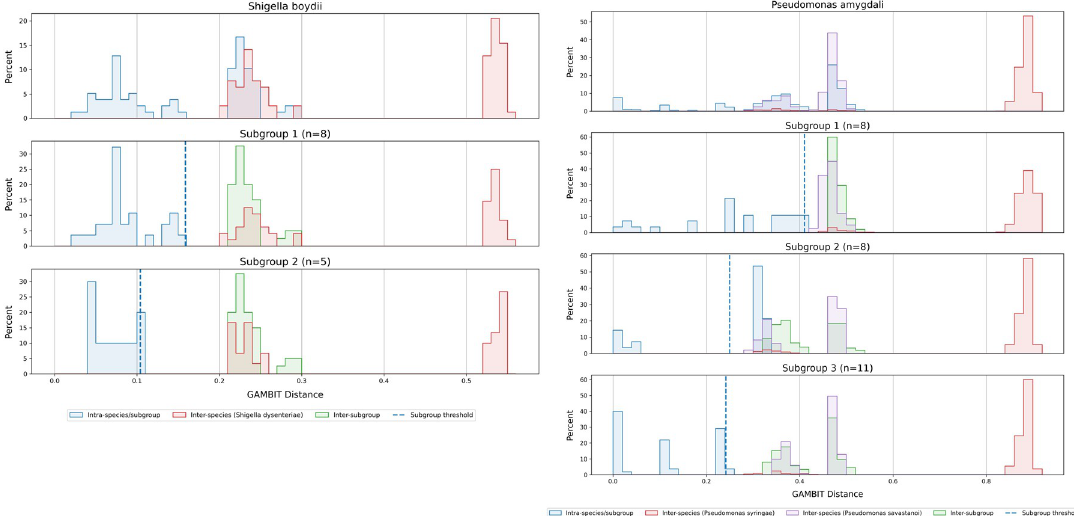
Fig 5. Distribution of intra- and inter-species GAMBIT distances for two species divided into subgroups in the GAMBIT reference database. In both subplots, the top panel shows the distribution of intra distances in blue and the distribution of inter distances to sister taxa in red and/or purple. The remaining panels show distance distributions for each subgroup. Intra-subgroup distances are shown in blue, inter-subgroup distances in green, and inter-species distances are as in the top panel. Subgroup thresholds are represented with a dashed blue line. A. Shigella boydii. Inter-species distances with Shigella dysenteriae are shown in red. B. Pseudomonas amygdali. Inter- species distances with Pseudomonas savastanoi and Pseudomonas syringae are shown in purple and red, respectively.